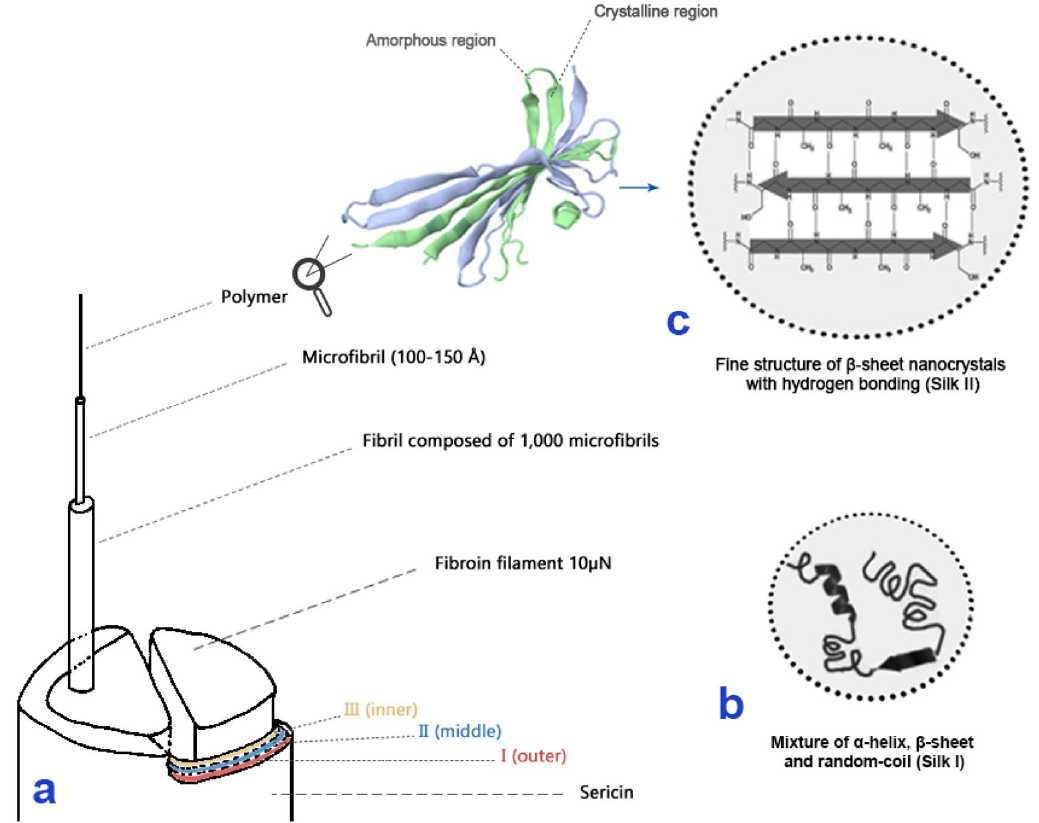
of the silk moth before extrusion) . (c) A representation of the secondary structure of secreted, solid Silk II. This figure was created by the first author using original drawing and opensource images edited with Adobe Photoshop